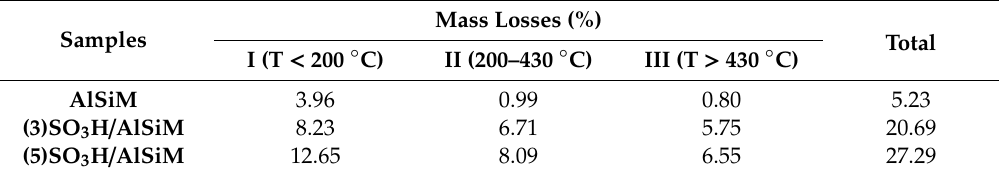
Figure 4. Thermal stability determined by TGA / DTG of AlSiM and (3 or 5)SO 3 H / AlSiM ( a ) TGA and ( b ) DTG. Table 3. Mass loss (%) with respective temperature ranges.